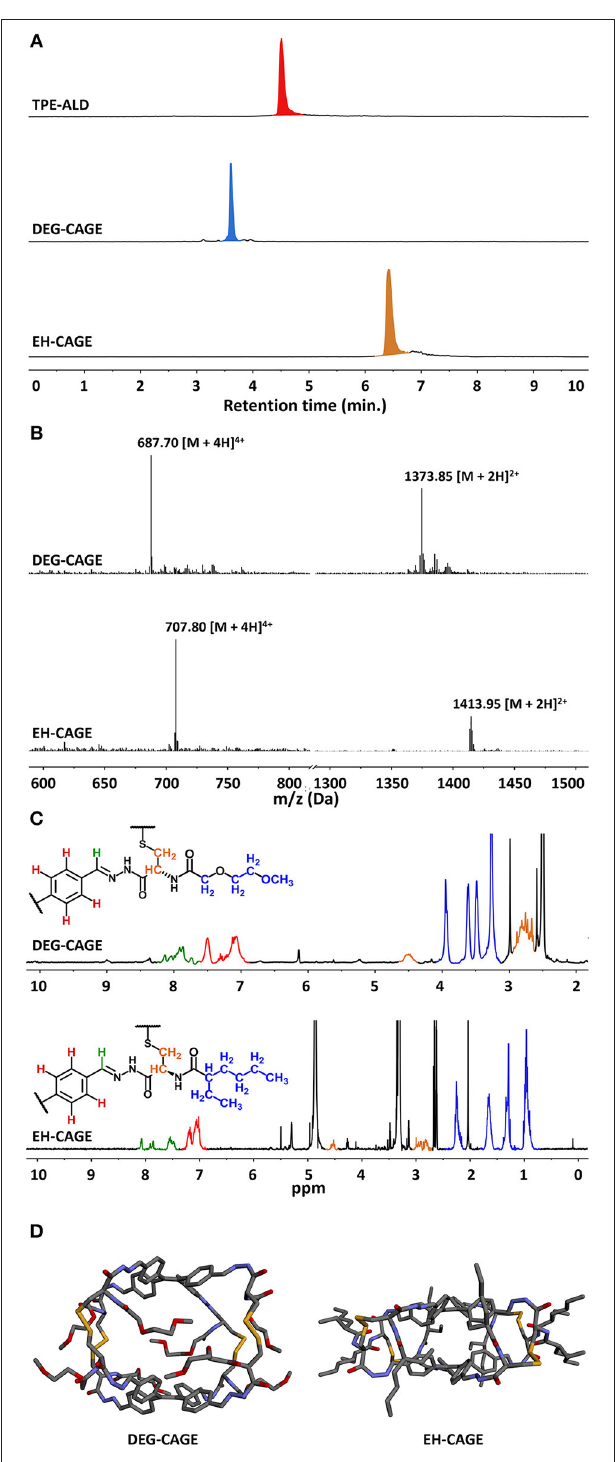
FIGURE 3 | Characterization of described cages. (A) Comparison of HPLC chromatograms (310nm) of TPE-ALD, DEG-CAGE and EH-CAGE showing the formation of a single product by self-assembly, (B) ESI-MS mass spectra of modified cages, calculated m/z for DEG-CAGE: [M + 4H] 4 + 687.2265, found 687.70, calculated m/z for [M + 2H] 2 + 1373.4458, found 1373.85; calculated m/z for EH-CAGE [M + 4H] 4 + 707.3408, found 707.80, calculated